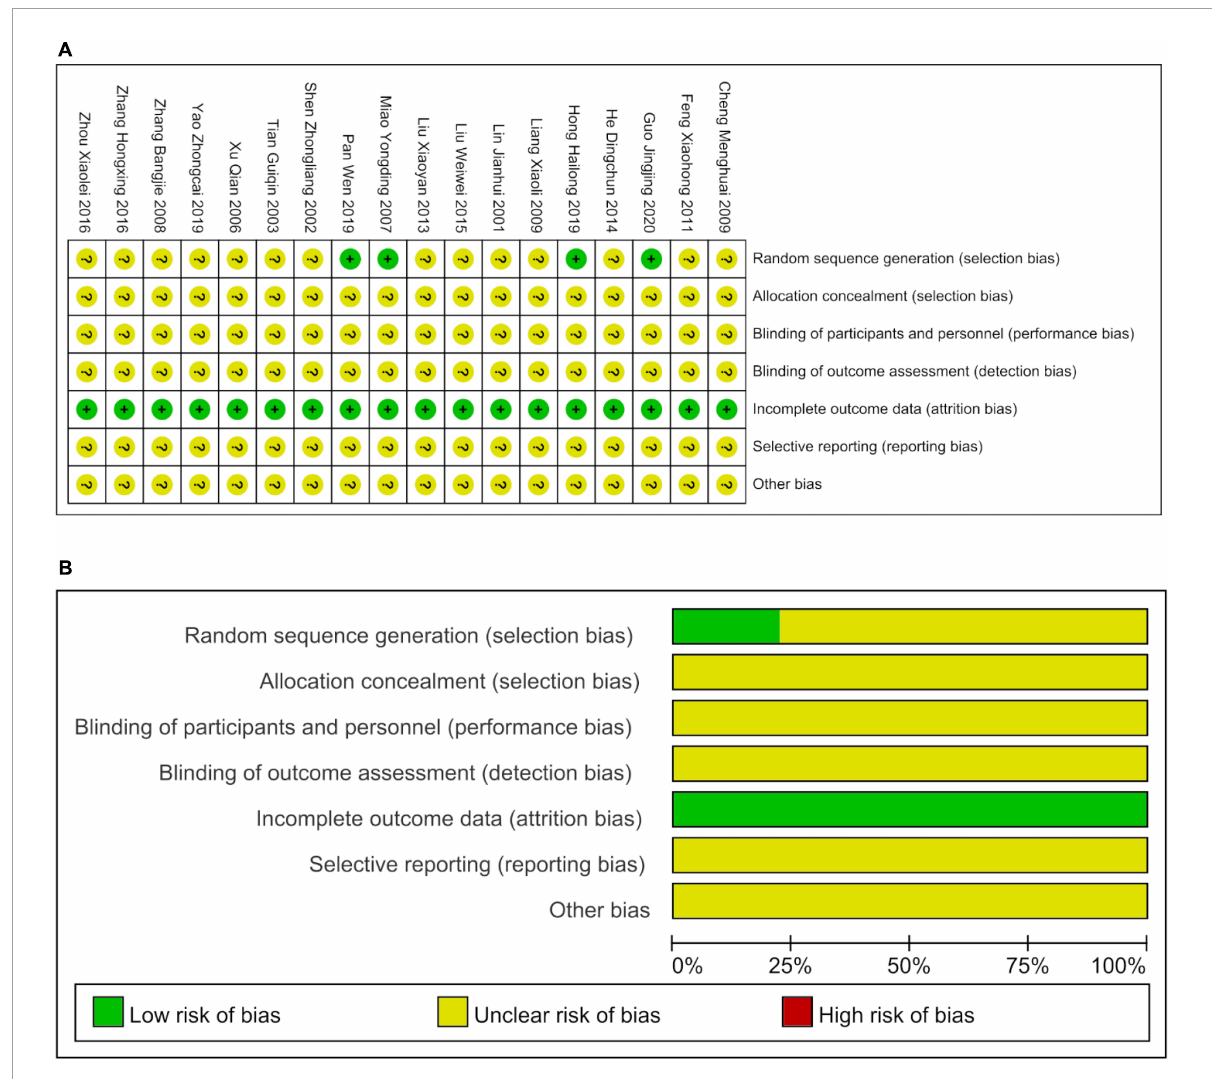
FIGURE2 The bias risks of included studies. (A) The details of the bias risks. (B) The percentages of the risk of bias.